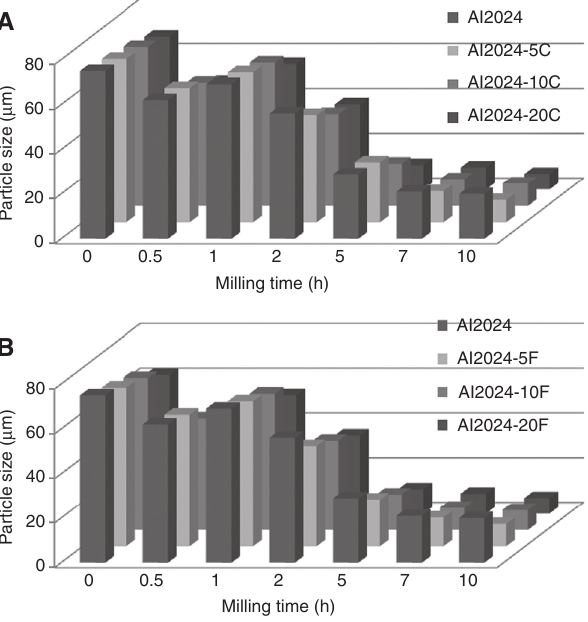
Figure 7 Effect of milling time and B particle size: (A) Al2024-B